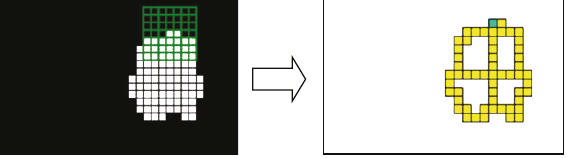
Figure 13: An example of boundary